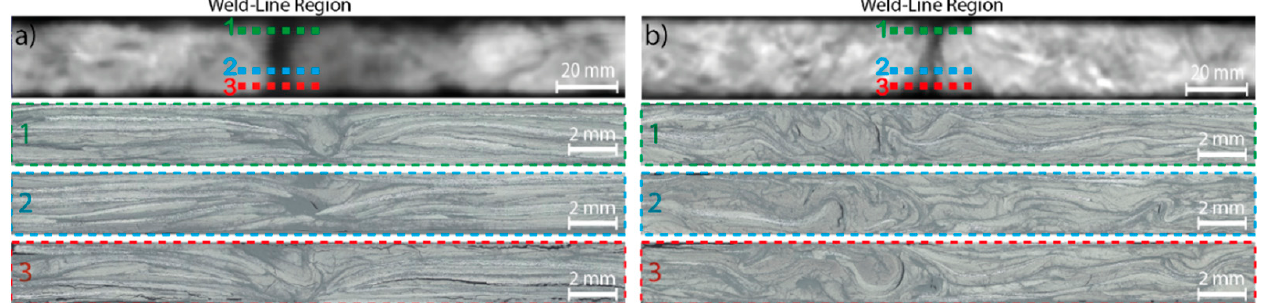
Figure 5. mm-wide in-plane EC (magnitude) image ( a ) Butt tensile coupon (top); ( b ) Flow tensile